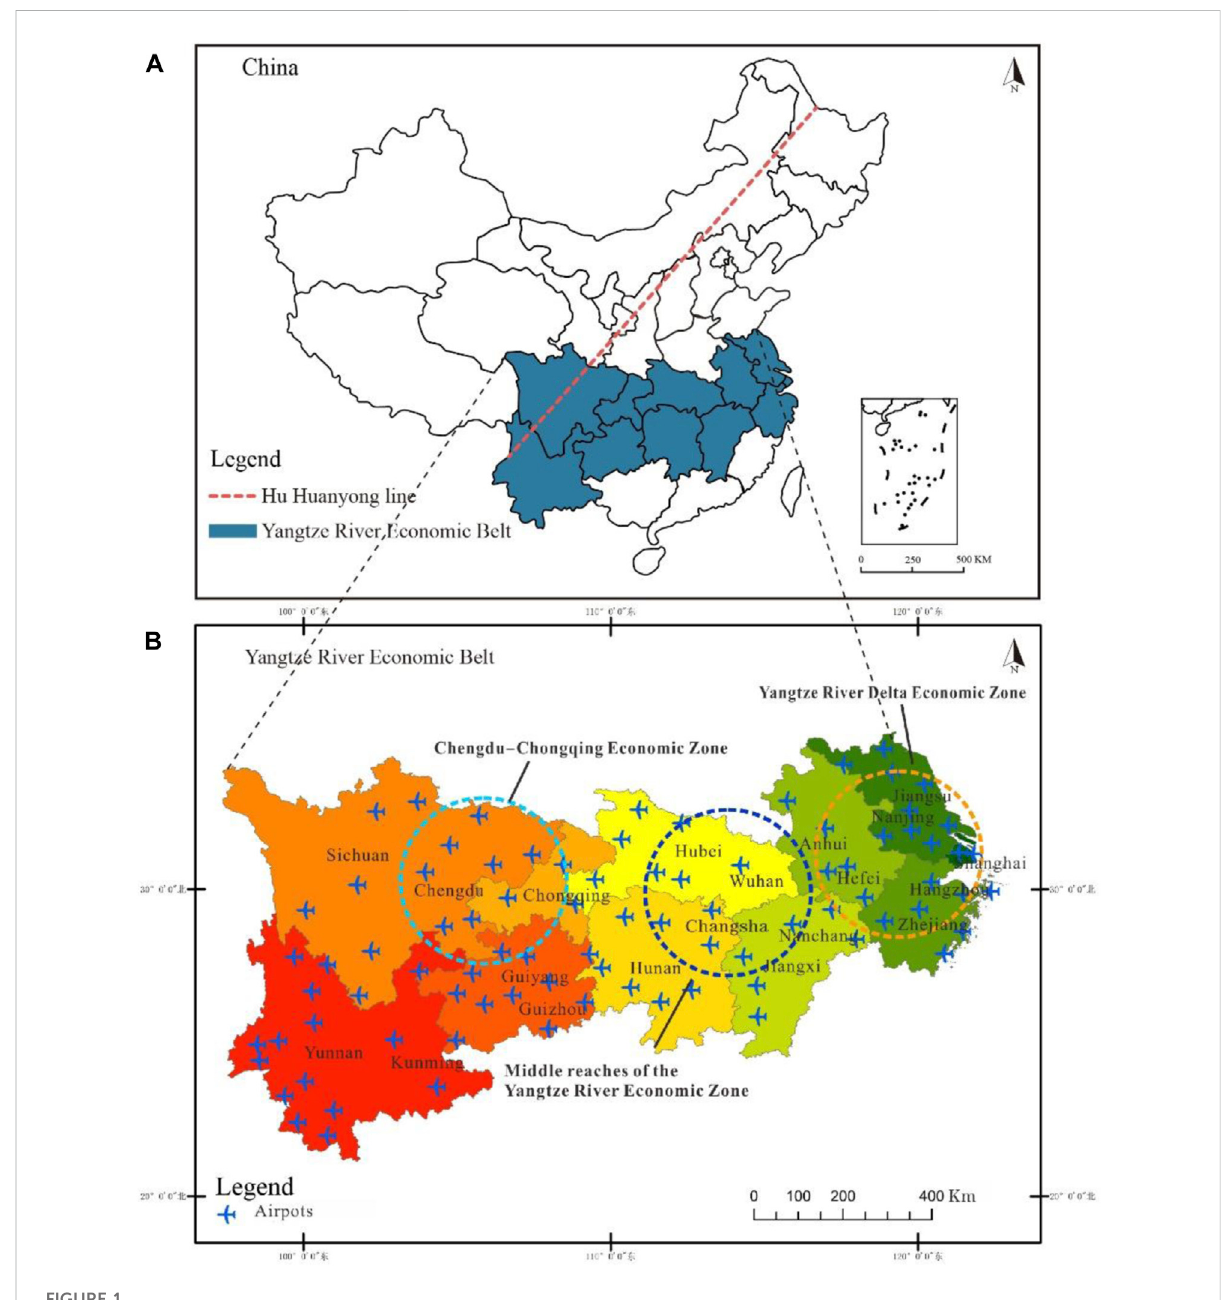
FIGURE 1 Study site.: (A) China; (B) the Yangtze River Economic